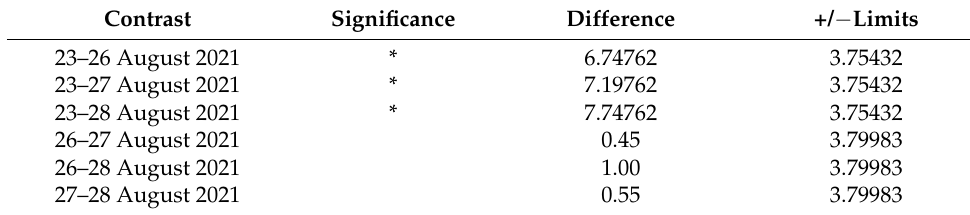
Figure 9. Relative humidity in the study area during the selected days of the test. The central value of the box-and-whisker plot is the median of the data, while the “+” represents the mean. The lower and upper borders correspond to the first and third quartiles, respectively. Finally, the ends of the whiskers correspond to the minimum and maximum values of the analyzed data. Table 3. Results of Duncan’s multiple range test for relative humidity